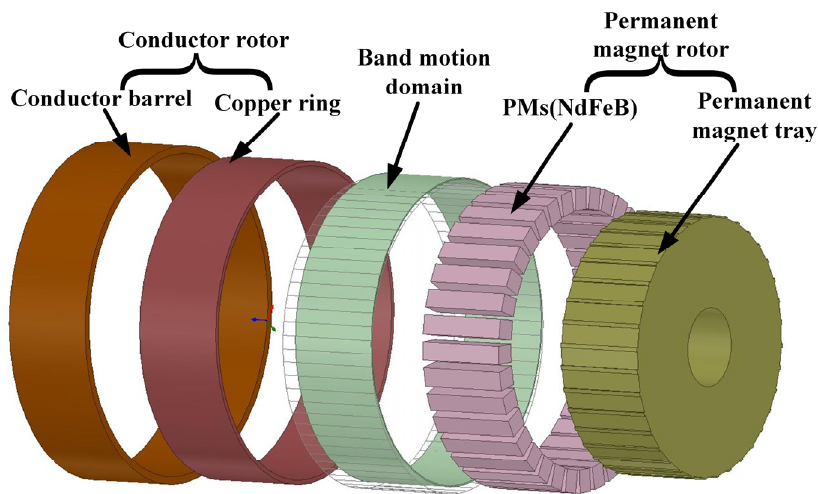
Figure 5. Simulation model of CPMG.